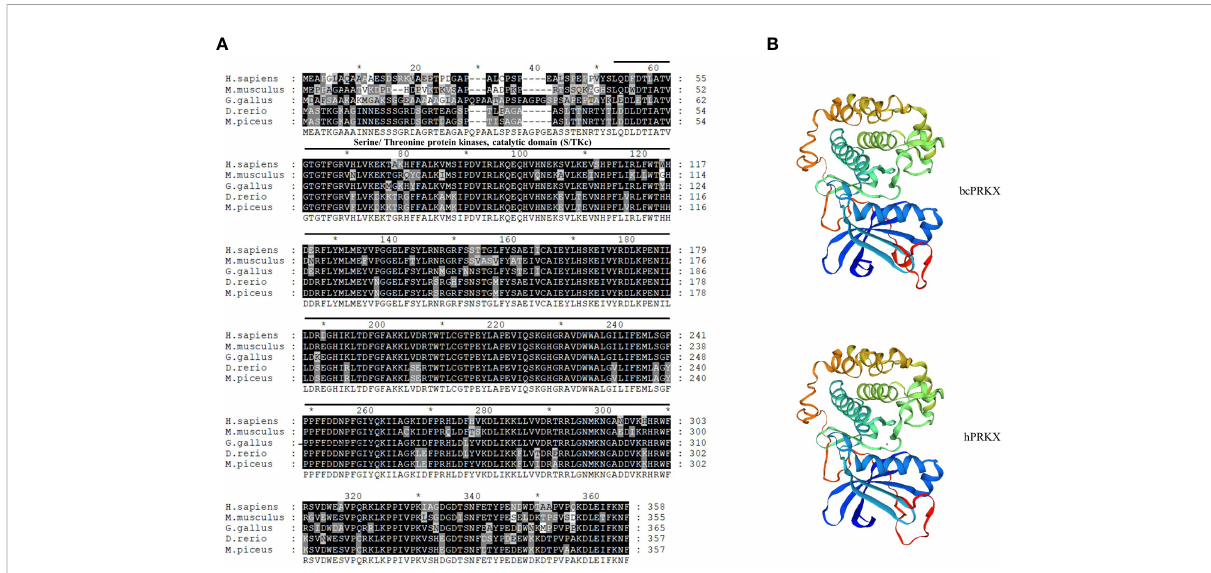
FIGURE 1 PRKX of black carp (bcPRKX) is conserved among species. (A) Amino acid sequences of PRKX from 5 species were aligned by using GeneDoc, including human ( H. sapiens ), mouse ( M. musculus ), chicken ( G. gallus ), zebra fi sh ( D. rerio ) and black carp ( M. piceus ). (B) Comparison between the three-dimension structures of human PRKX and bcPRKX. These models were built by using SWISS-MODEL (SWISS-MODEL